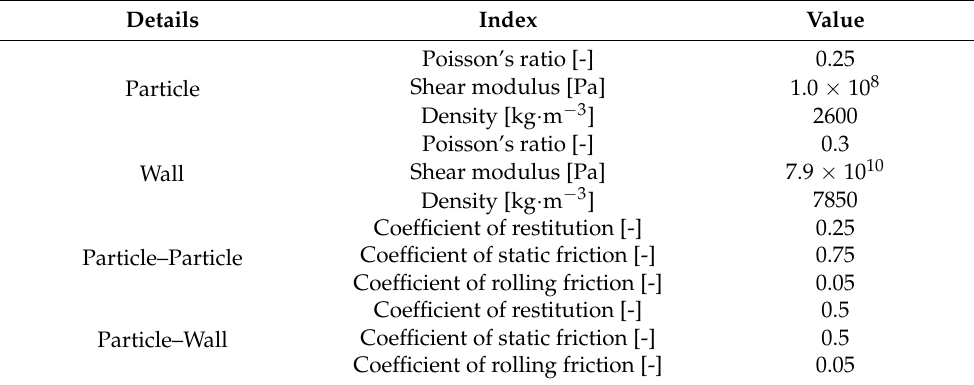
Figure 3. Mesh model of fluid computing domain. Table 1. Material parameters used in simulations.